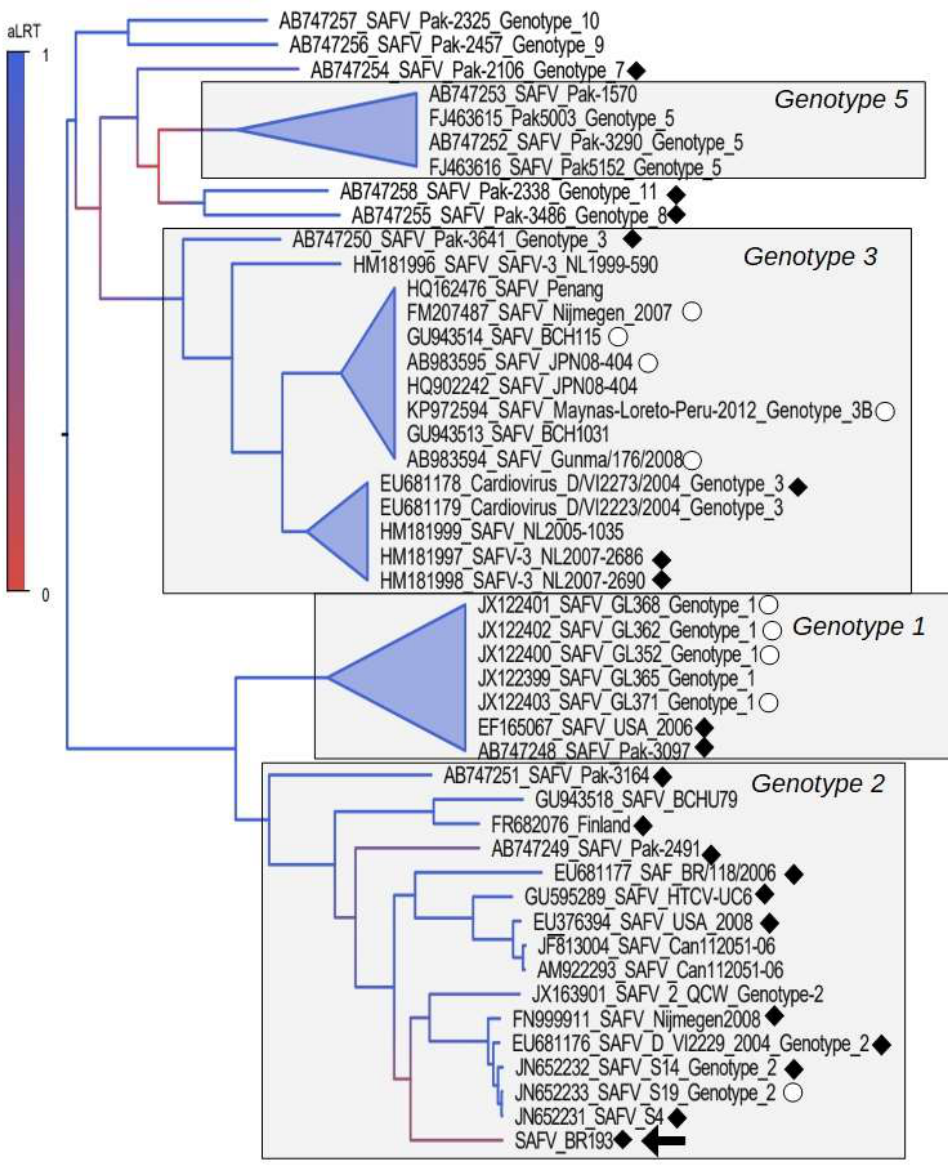
Figure 1. Maximum likelihood tree constructed using polyprotein region of Saffold viruses (SAFV). The Brazilian strain BR-183 described in this work is indicated by a filled arrow. A colored scale indicating the statistical support of each node, calculated using the approximate likelihood ratio test (aLRT), is shown in the tree. Phylogenetic groups corresponding to genotypes are limited by grey areas. The topology shows that genotype 1 is closely related to genotype 2, while genotype 3 is closely related to genotype 8. Genotype reference strains are indicated by open dots on the genome tree. Recombinant strains are indicated by filled diamonds in the tree. The scale bar under the tree represents the nucleotide substitutions per site.